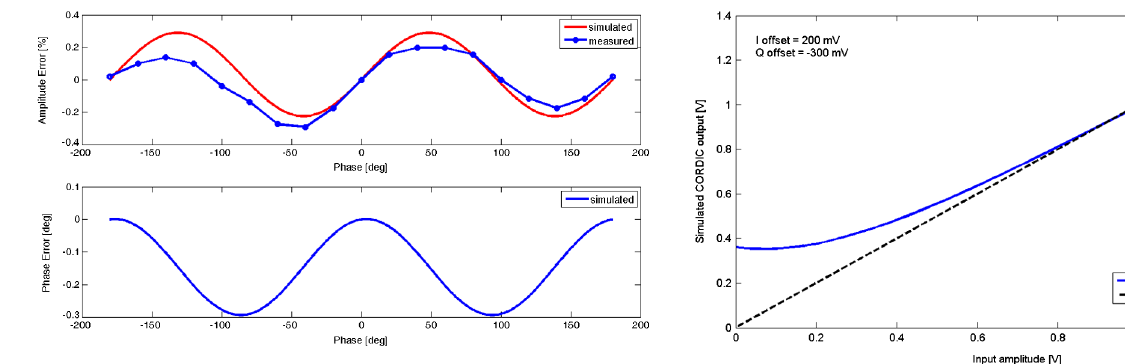
FIG. 6. Simulated linearity response of the IQ demodulator with I and Q offsets of 200 mV and (cid:3) 300 mV , respectively, and input phase of 45 (cid:2)